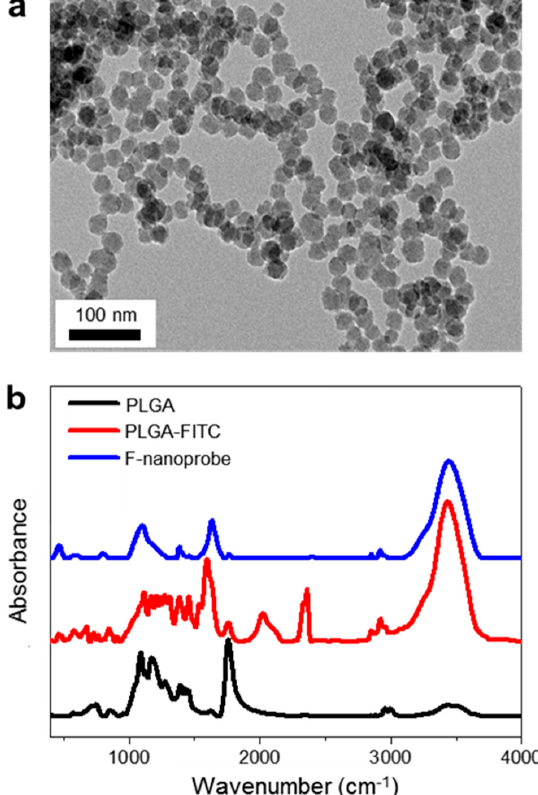
Figure 2a is a TEM image of the nanoprobes including FITC (F-nanoprobes). The nanoprobes